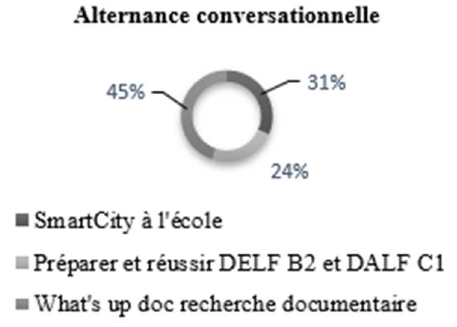
Fig. 3. Le degré d’alternance des tours de parole.